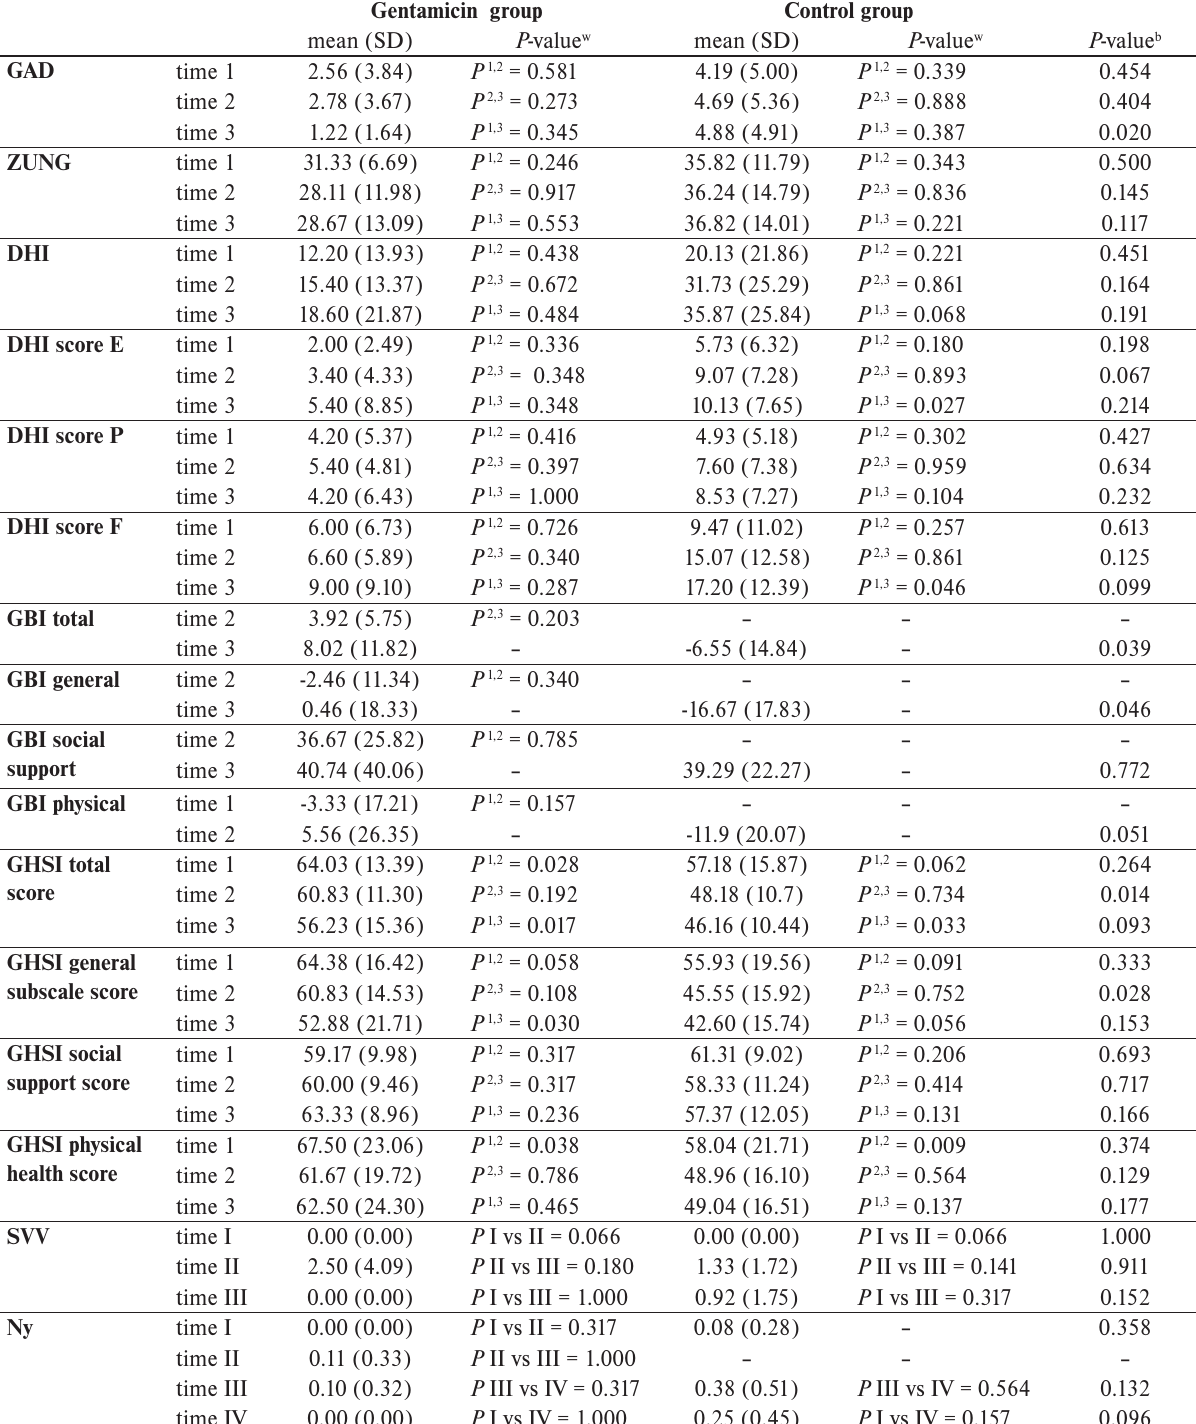
Table 3. Results -